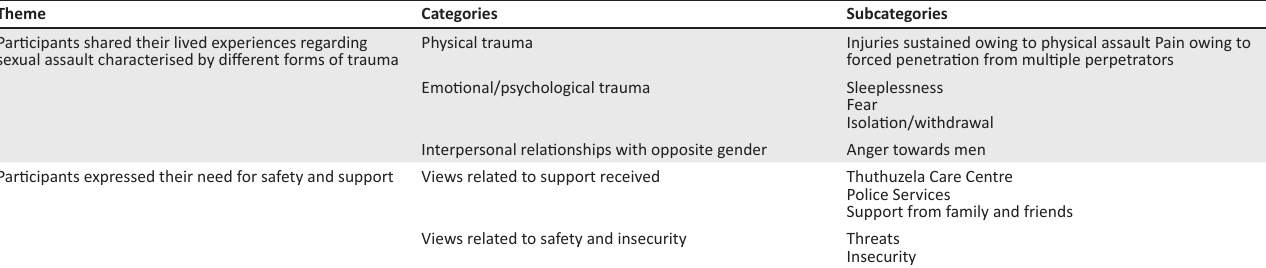
TABLE 1: Summary of